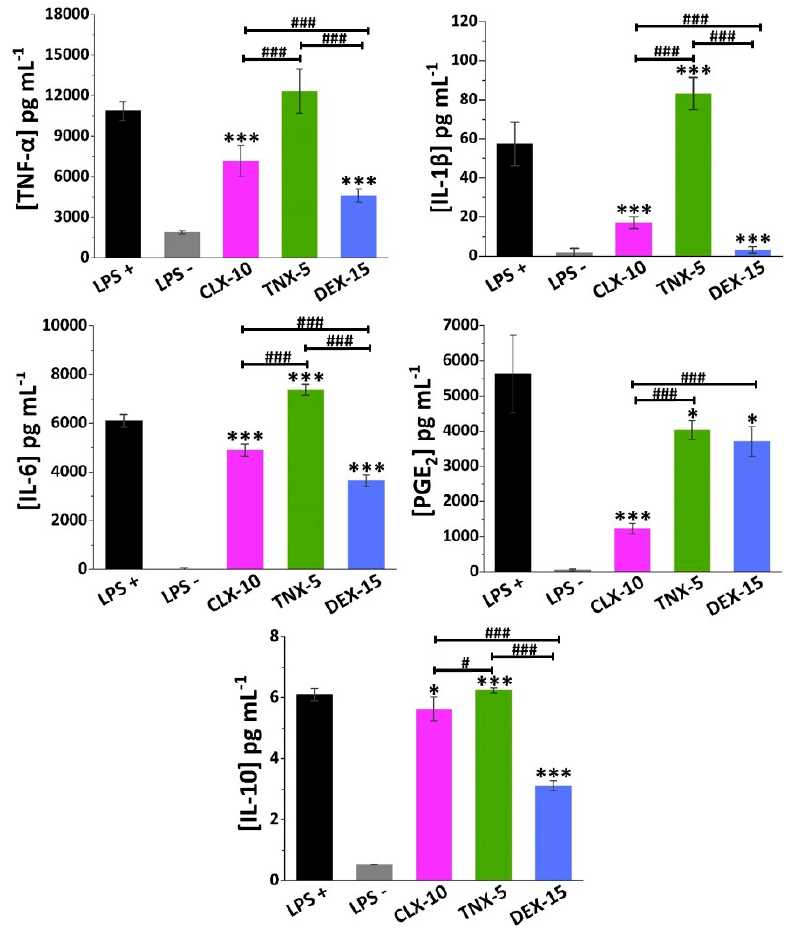
Figure 5. Effect of CLX-10, TNX-5 and DEX-15 (0.50 mg mL − 1 ) on the release of the inflammatory mediators TNF- α , IL-1 β , IL-6, PGE 2 and IL-10 in LPS+ RAW264.7 using ELISA kits. Data are represented as mean ± SD values. ANOVA between each NP formulation and LPS+ (* p < 0.05 and *** p < 0.001) and between NPs ( # p < 0.05 and ### p < 0.001) were performed.